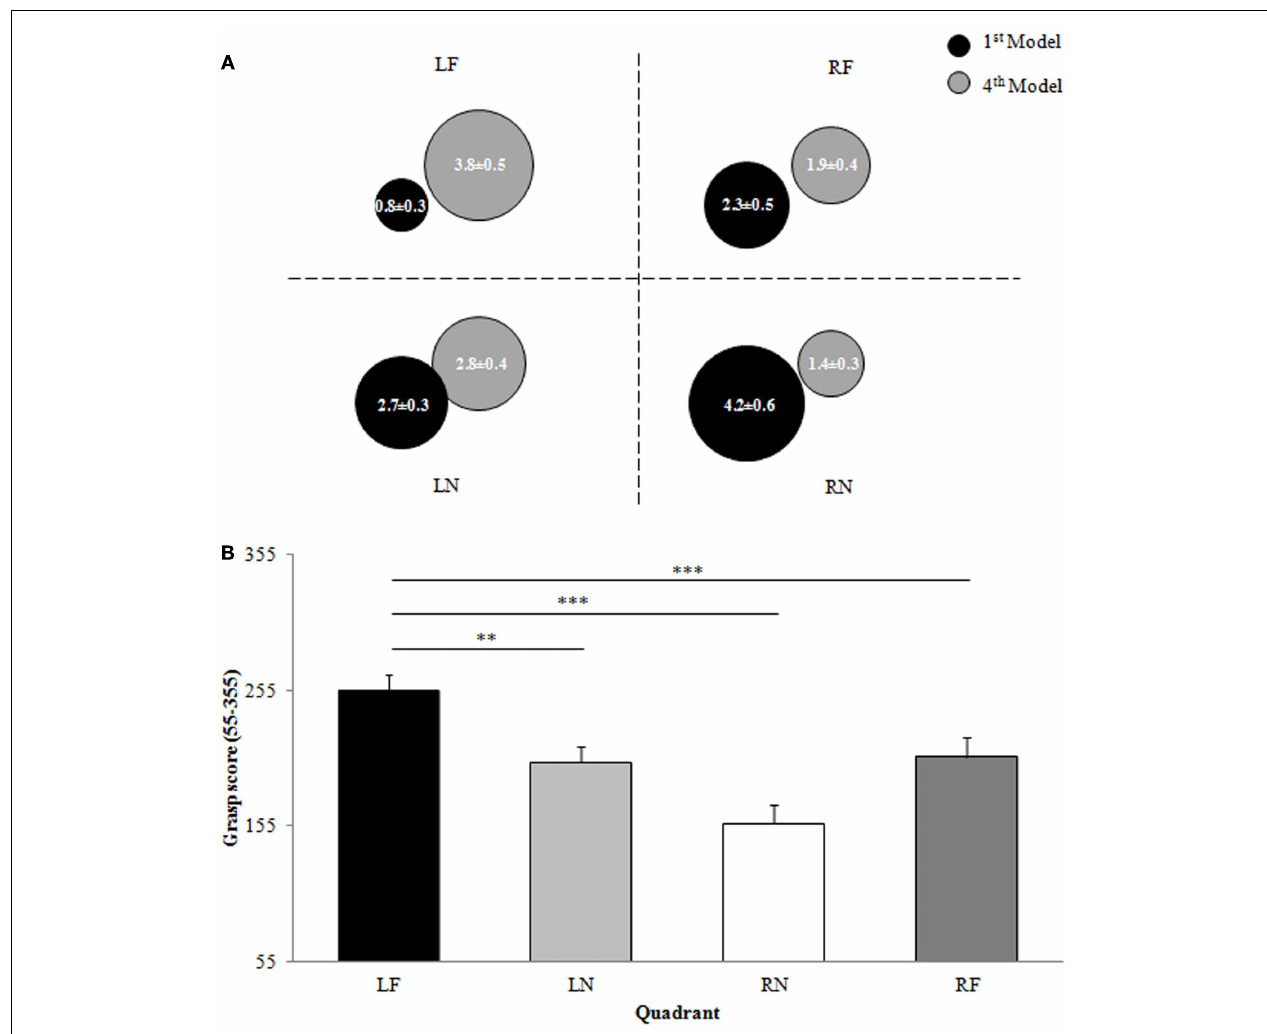
errors. (B) Overall grasp score for each quadrant of space. Data are means and standard errors. LF, left far; LN, left near; RN, right near; RF, right far. * p < 0.05, ** p < 0.01, *** p < 0.001 with respect to